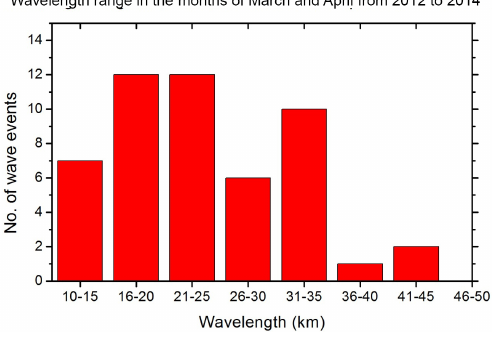
Figure 4. The distribution of observed periods.